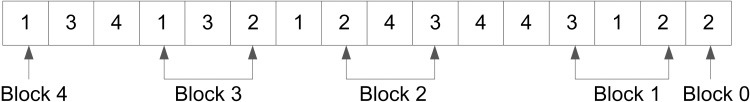
Key operation blocks.